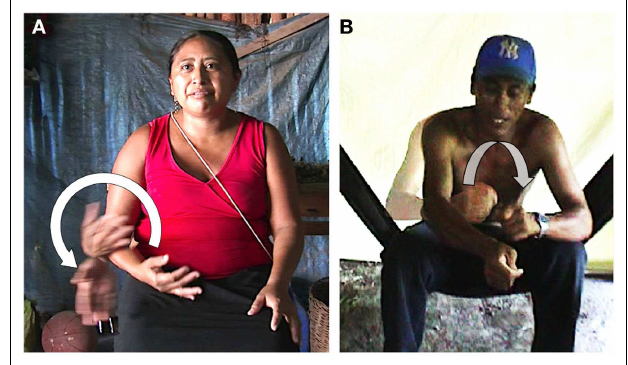
FIGURE 5 | Summary of the use of gestural space around the speaker inYucatec Maya. FIGURE 6 | Example of rolling gesture (A) 360˚ and (B)